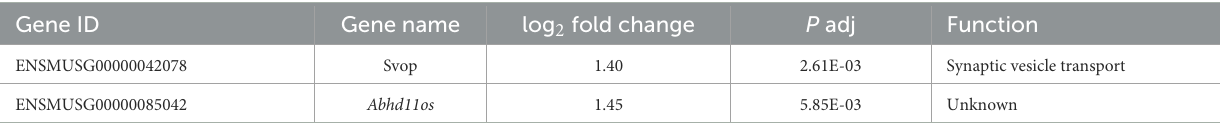
TABLE 6 Significantly upregulated genes in murine astrocytes 24h after exposure to 2Gy X-rays. Gene